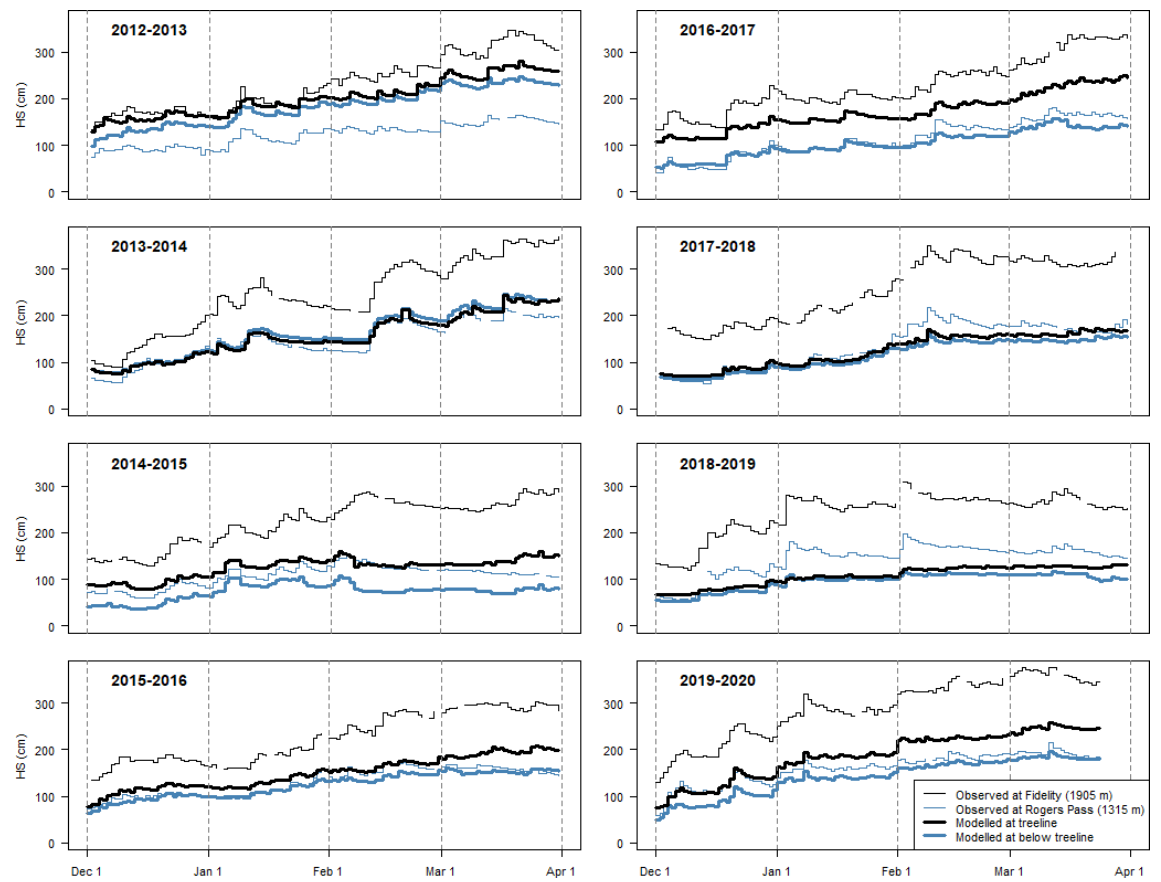
Figure 4. Modelled snow height (HS) at treeline and below-treeline grid points in Glacier National Park compared to field observations from study plots at similar elevations. Table 5. Verification of modelled snow height and snowfall with field